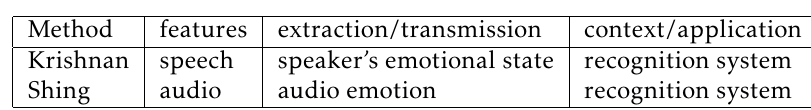
Table 2. Extraction approaches on audio